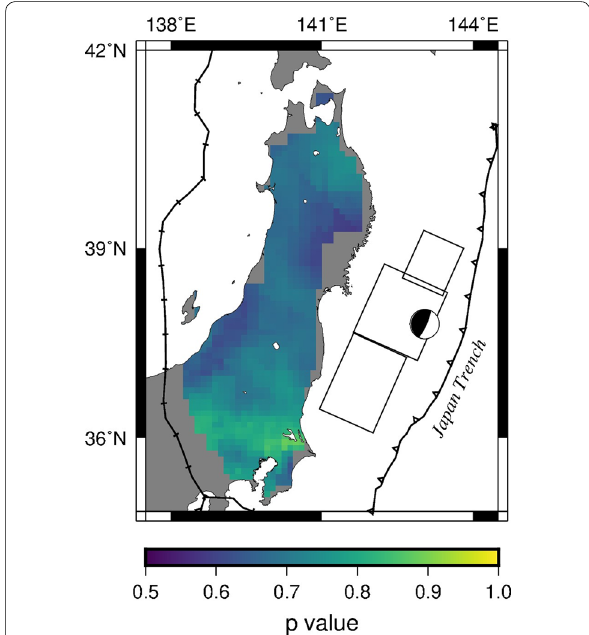
Fig. 9 p -value distribution of the horizontal ground displacement rates ( p d ) after the 2011 Tohoku Earthquake for each observation